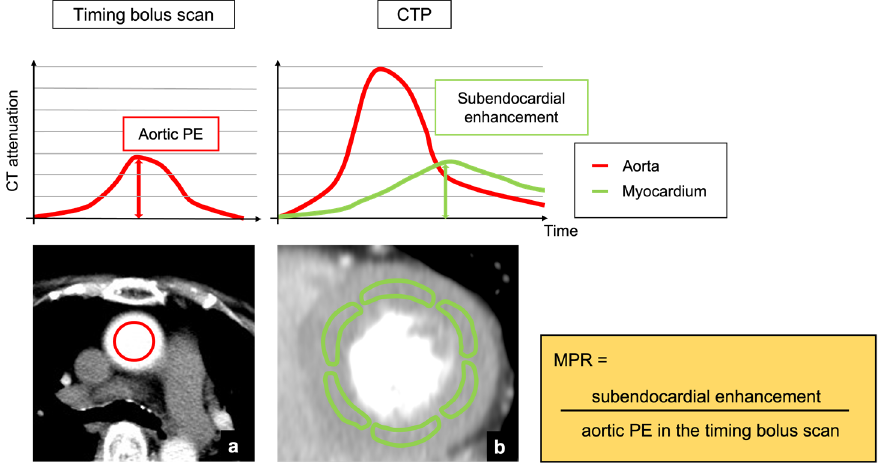
Figure 1. Analysis of MPR derived from myocardial CTP and timing bolus scan. ( a ) An axial image at the level of the ascending aorta in the timing bolus scan. ( b ) A short-axis view of left ventricle which was obtained from the static CTP image. PE was defined as the difference between baseline and peak CT attenuation of the aorta. A sub-optimal phase of dynamic CTP series was selected as static CTP image. MPR was calculated as follows: MPR = subendocardial enhancement/aortic PE in the timing bolus scan. CTP, computed tomography perfusion; PE, peak enhancement; MPR, myocardial perfusion ratio.